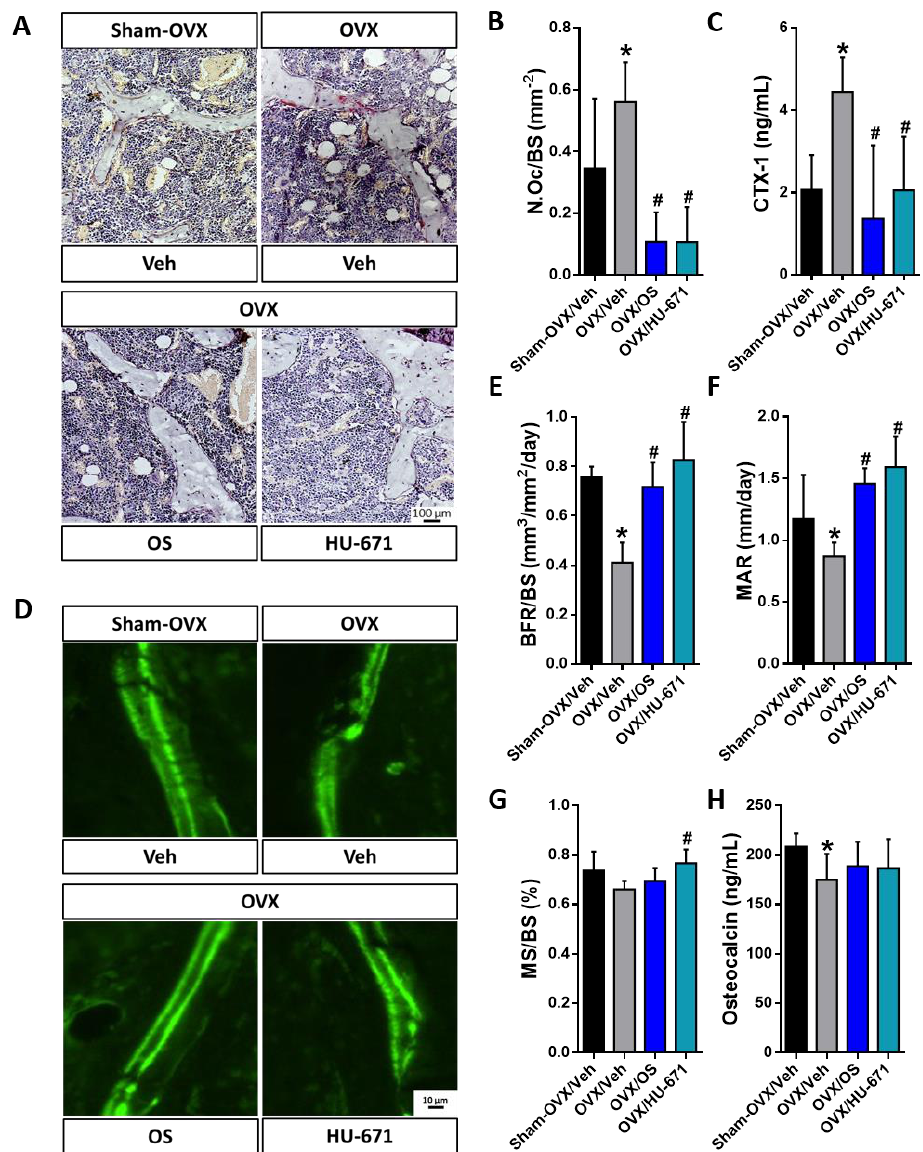
Figure 5. Both OS and HU-671 have bone anabolic and anti-catabolic e ff ects in vivo. Both OS (3 mg / kg / day) and HU-671 (0.5 mg / kg / day) reduced osteoclastogenesis, as measured by the reduction of TRAP + osteoclasts per trabecular surface area (NOc / BS) ( A , B ) as well as normalization of serum CTX-1 levels ( C ). Similar improvements in the bone formation rate (BFR / BS) ( E ) and the mineral apposition rate (MAR) ( D , F ) were found in OVXed mice treated with either OS or HU-671. The mineralized surface (MS / BS) was increased only in HU-671-treated OVXed mice ( G ). Both drugs were not e ff ective at fully reversing the reduction in serum osteocalcin levels ( H ). Data represent the means ± SDs obtained in 4–8 mice per condition. * p < 0.05 versus the Sham-OVX / Veh-treated group, # p < 0.05 versus the OVX / Veh-treated group.